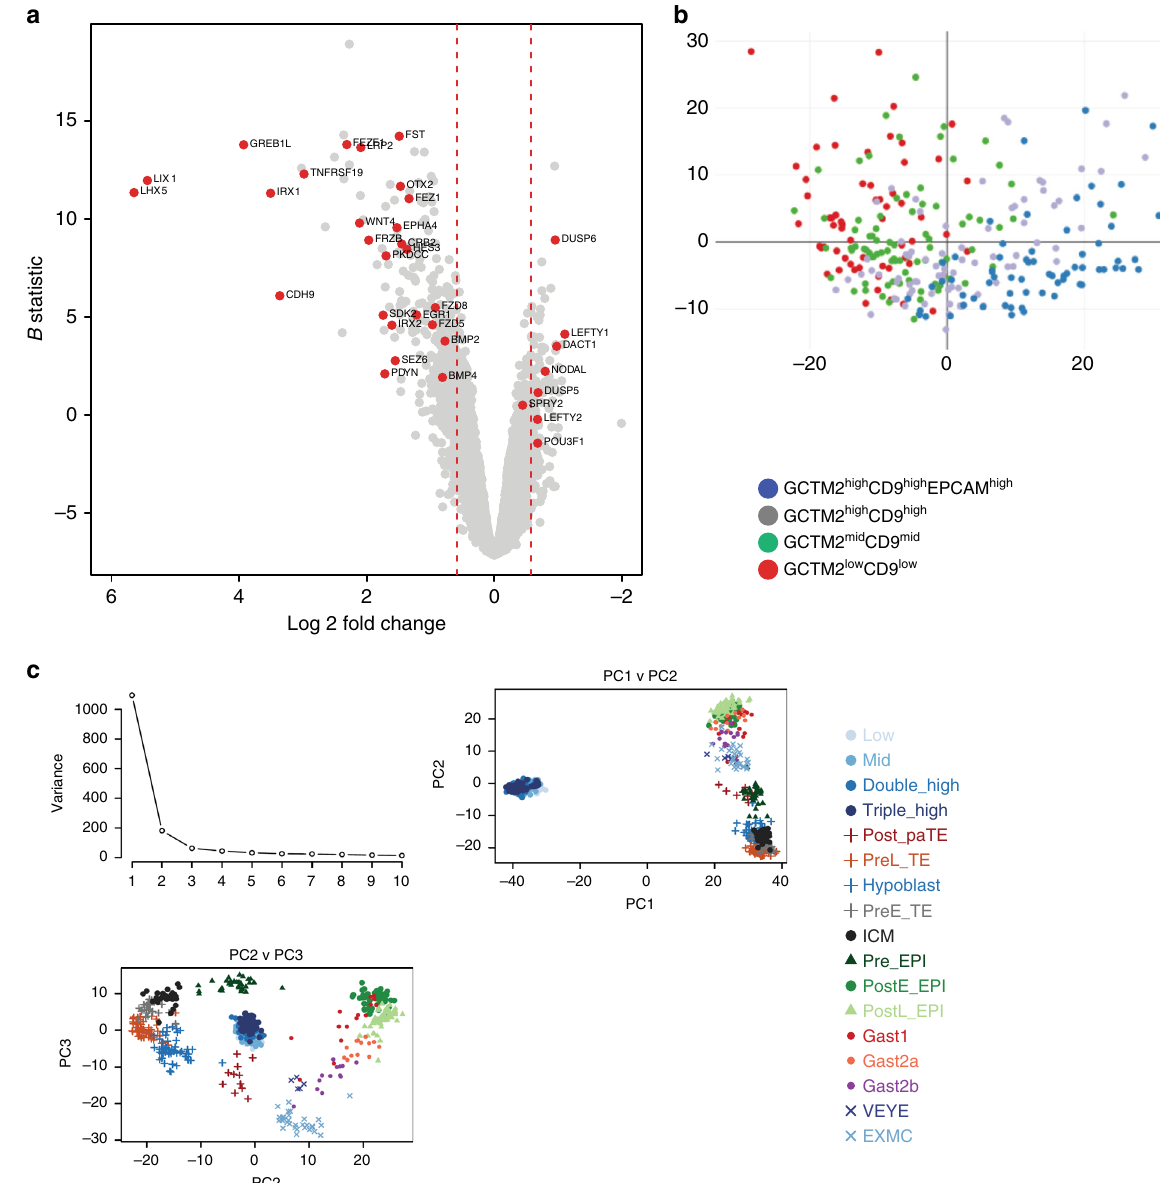
Fig. 8 Global gene expression analysis of hPSC subpopulations by RNA-seq. a Volcano plot illustrating differentially expressed genes in GCTM- 2 high CD9 high EPCAM high versus general (unsorted) populations. b Principal component analysis of single-cell RNA-seq data on GCTM-2 high CD9 high EPCAM high , GCTM-2 high CD9 high , GCTM-2 mid CD9 mid , and GCTM-2 low CD9 low subpopulations. c Joint species principal component analysis of single-cell RNA-seq data on GCTM-2 high CD9 high EPCAM high (HHH), GCTM-2 high CD9 high (HH), GCTM-2 mid CD9 mid (MID), and GCTM-2 low CD9 low (LOW) subpopulations alongside cynomolgus embryo data from ref. 30 ; single embryo cells classi fi ed according to Houghton et al. 30 . Top left: screeplot demonstrating the amount of variability in the data accounted for by each component; top right: graph displaying data distribution along fi rst and second components; bottom left: graph displaying data distribution along the second and third components. Color and shape of point indicate sample phenotype, each point representing a single